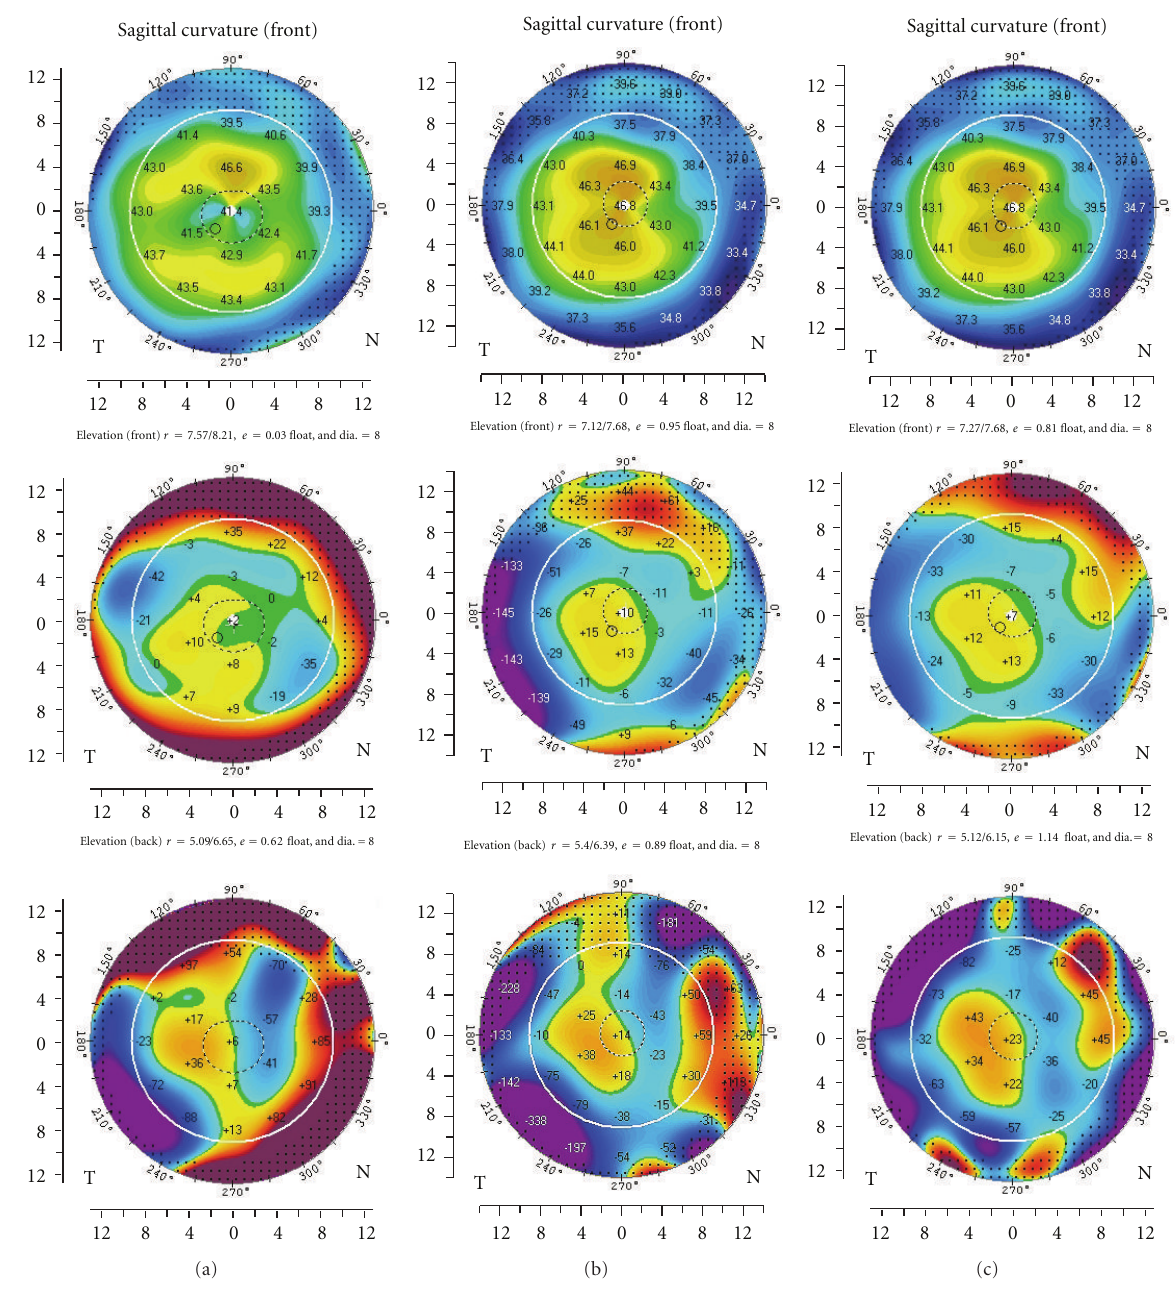
Figure 2: Pentacam corneal topography before (a), 7 months after (b), and 1 year after femtosecond laser-assisted LASIK (c). Note the relatively stable topography postoperatively and the substantially unchanged anterior and posterior elevation